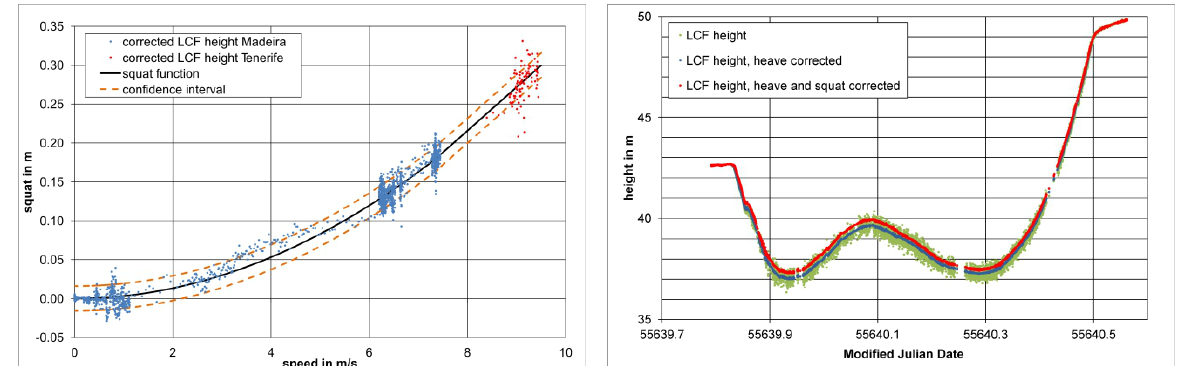
Figure 19. Corrected heights of LCF with respect to static heights, resulting quadratic squat function and related confidence interval.